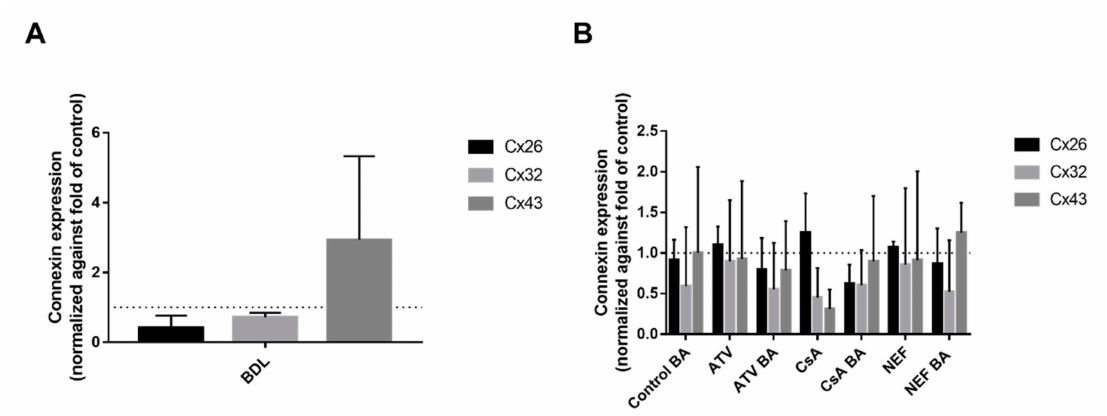
Figure 7. Quantification of immunohistochemistry and immunocytochemistry analysis results. Cellular localization of Cx26, Cx32 and Cx43 was revealed by immunohistochemistry (Figure 5) or immunocytochemistry (Figure 6) analysis with nuclear counterstaining using DAPI, followed by quantification of the obtained images via ImageJ software. The ratio of the area of occurrence of the particular connexin to the number of nuclei was measured and expressed as relative alterations compared to the control. ( A ) Liver sections were obtained from male mice following bile duct ligation (BDL) for 20 days. Data were processed by a parametric student t-test with Welch’s correction. Data are expressed as means +/ − SD compared to sham-operated animals (Sham n = 3; BDL n = 3) (N = 1). ( B ) Human hepatoma HepaRG cells were exposed to cholestatic drugs either in the absence or presence of a 50 × concentrated mixture of bile acids (BA) for 72 h and compared to untreated human hepatoma HepaRG cells, indicated in the figure as control. Data were processed by a parametric one-way ANOVA followed by post hoc tests with Dunnett’s correction. Data are expressed as means +/ − SD compared to control samples (control n = 3; control BA n = 3; ATV n = 3; ATV BA n = 3; CsA n = 3; CsA BA n = 3; NEF n = 3; NEF BA n = 3) (N =